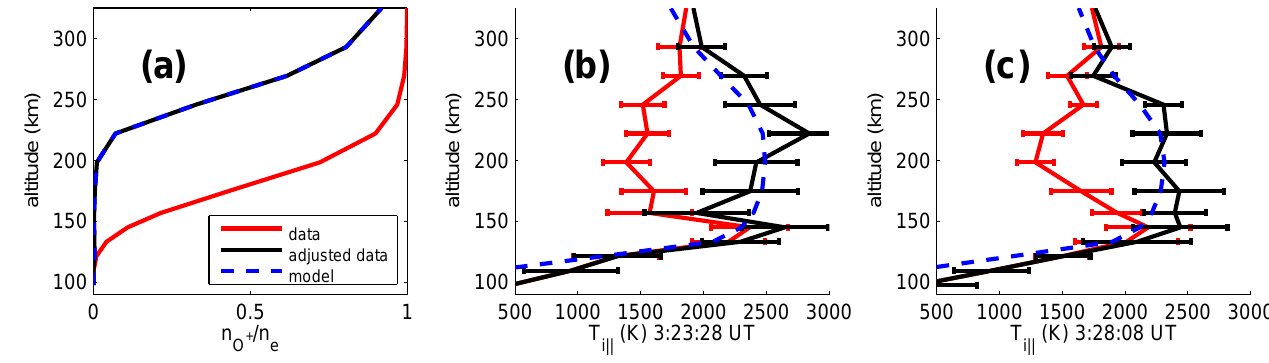
Fig. 7. ISR ion temperature profiles reprocessed with TRANSCAR ion composition profile. Panel (a) Ion composition profiles from standard Sondrestrom analysis and TRANSCAR model. Panels (b) and (c) Temperatures from Sondrestrom analysis and from reprocessing of data with TRANSCAR composition